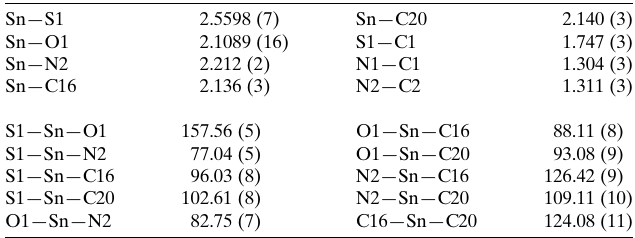
Table 1 Selected geometric parameters (A˚ , (cid:4)